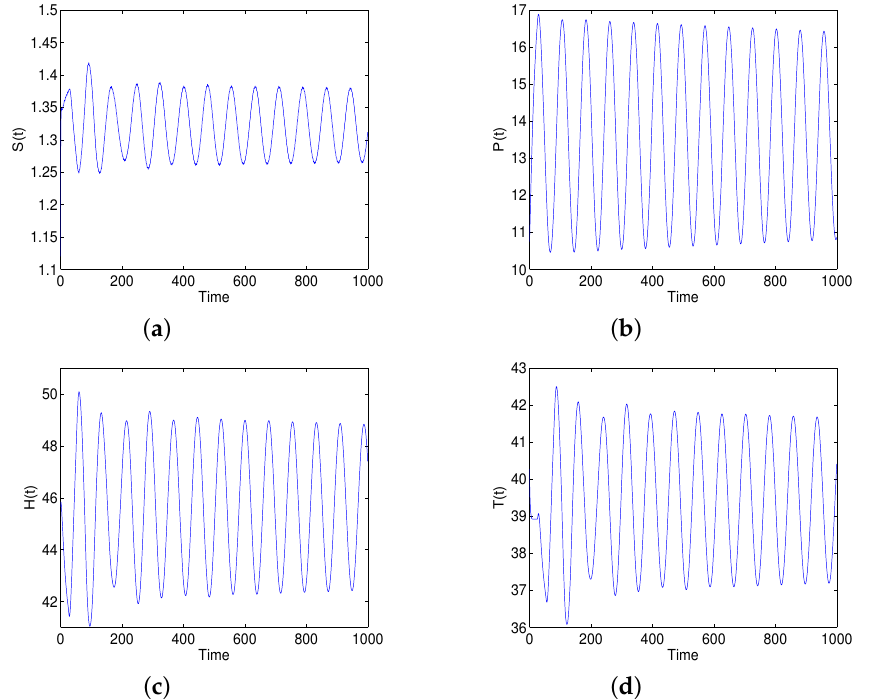
Figure 4. The time plot of ( a ) susceptible population, ( b ) psychological addicts, ( c ) physiological addicts and ( d ) drug-users in treatment for τ 2 = 25.9358 > τ 20 = 20.8839 with A = 2, d = 0.02, β 1 = 0.016, β 2 = 0.028, π = 0.03, γ = 0.095, θ = 0.5 and σ =